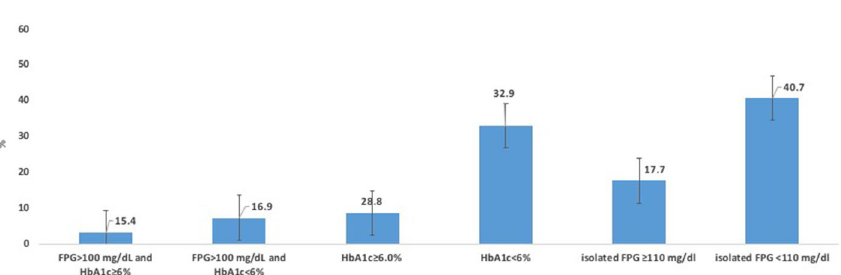
Figure 3. Proportion of patients reverting from prediabetes to normal glycaemia stratified by subtype of